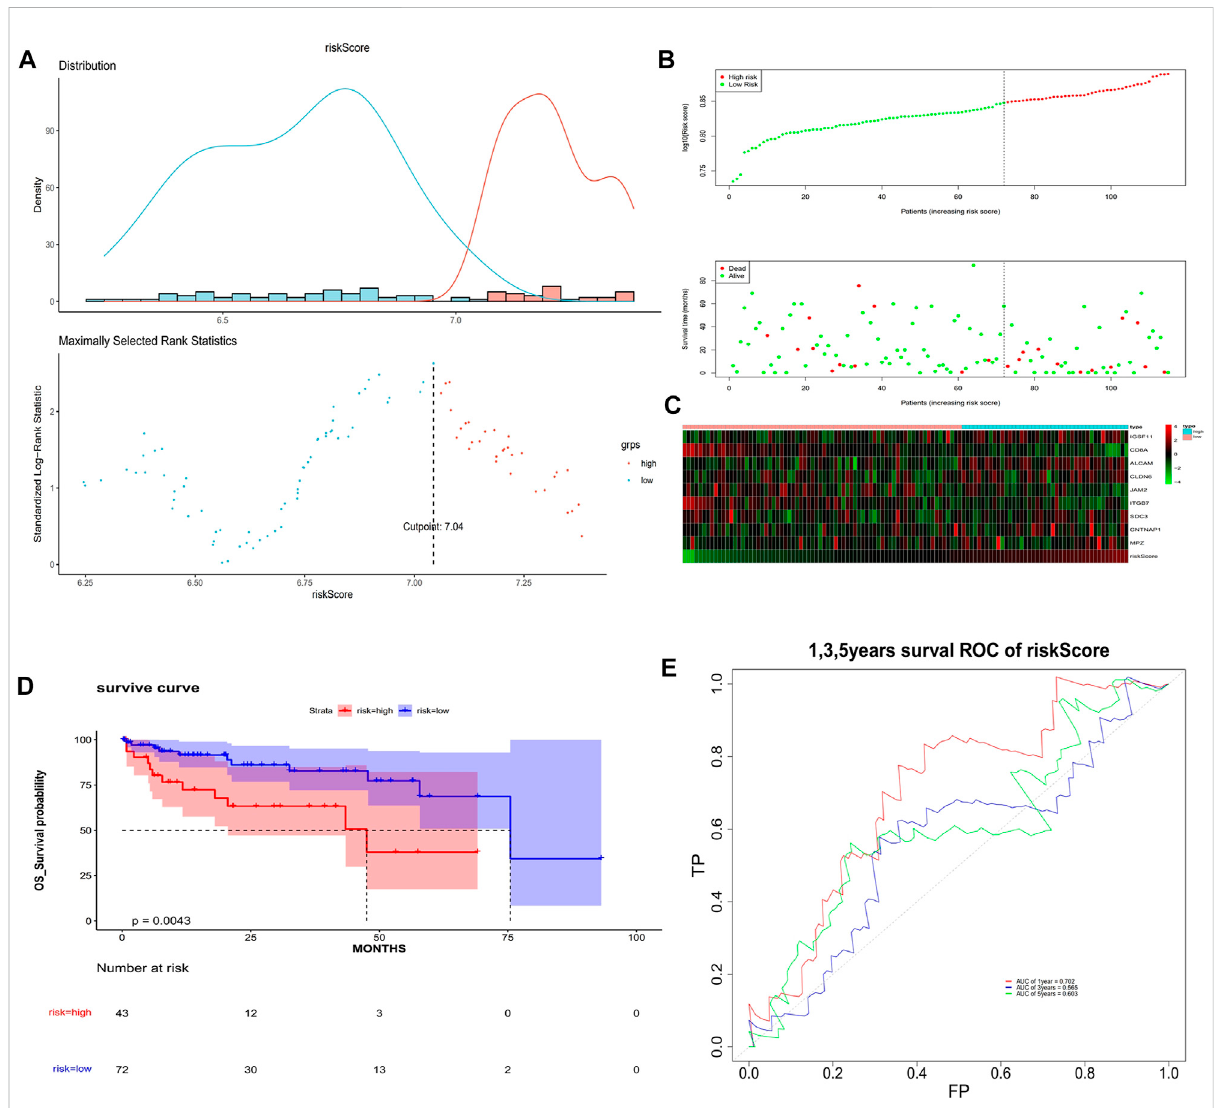
FIGURE 6 Validation of the risk model. (A) Optimal threshold screening for risk distribution in the validation set. (B) The risk score, survival time of patients in the validation set. (C) The expression of model genes in the validation set. (D) Survival curve of high- and low-risk patients in the validation set. (E) ROC curves of the risk model in the validation